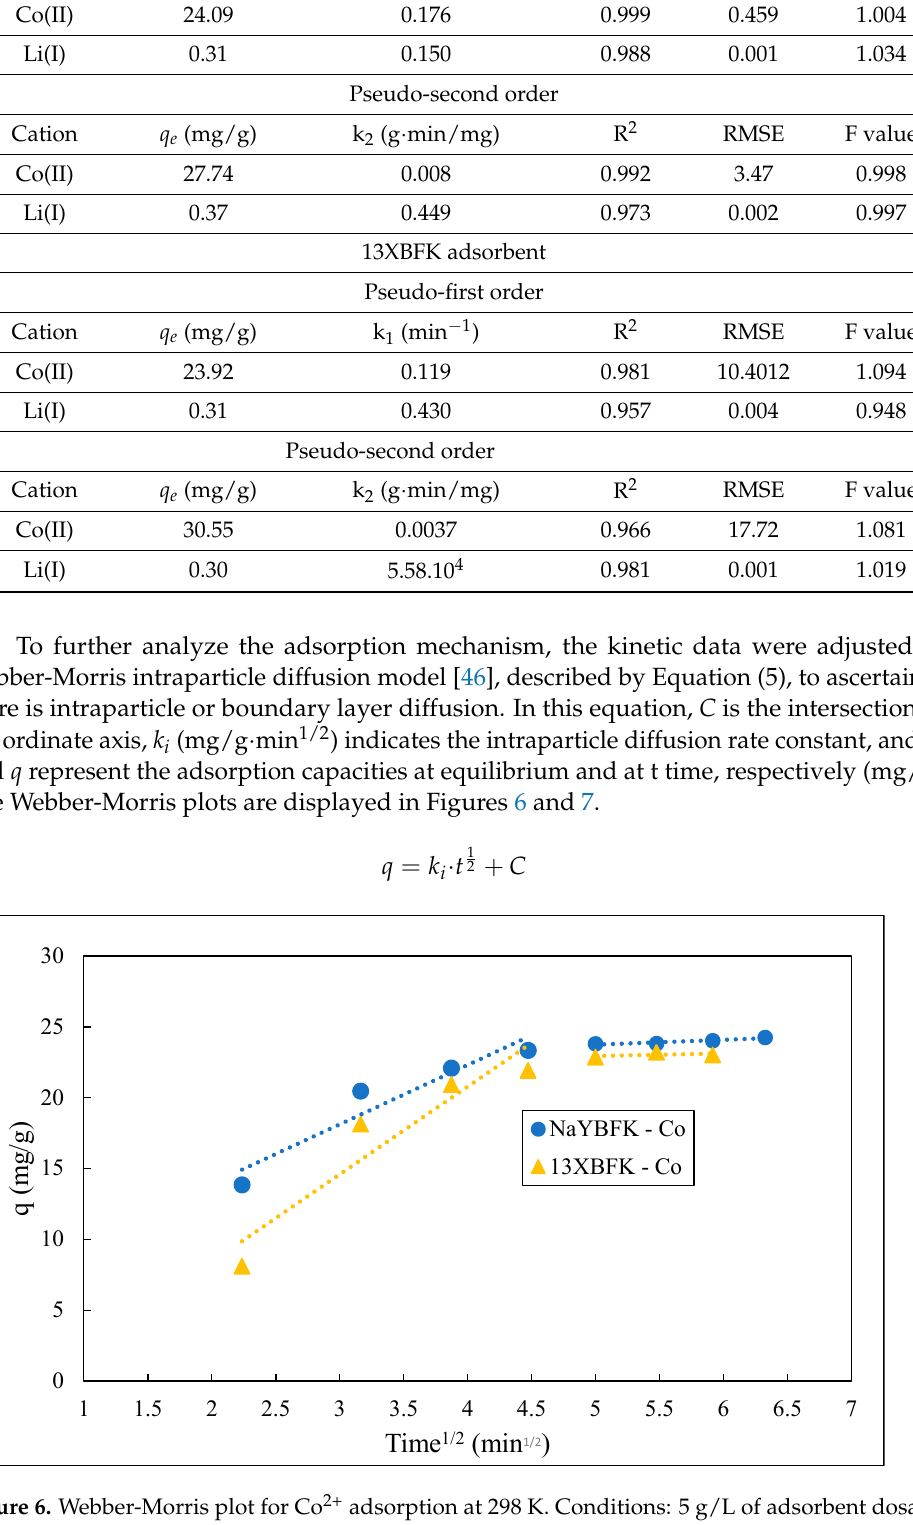
Figure 7. Webber-Morris plot for Li + adsorption at 298 K. Conditions: 5 g/L of adsorbent dosage, 1100 rpm, and 20 mg/L of initial Li + concentration. As it can be observed in Webber-Morris plots, except for the case of lithium adsorp- tion onto 13XBFK, all the plots can be divided in two linear sections. The first one corre- sponds to the diffusion of ions though the external surface of the adsorbent (film diffu- sion), while the second one corresponds to intraparticle diffusion. In the case of lithium adsorption onto 13XBFK only a straight line is observed: this indicates that in this case only intraparticle diffusion is noticeable. Additionally, none of the curves cross the origin which implies that, according to this model [46], the intraparticle diffusion, although im- portant, is not the rate-limiting step in the adsorption process. So, the rate-limiting step is the adsorption process, in agreement with pseudo-second-order model assumption.